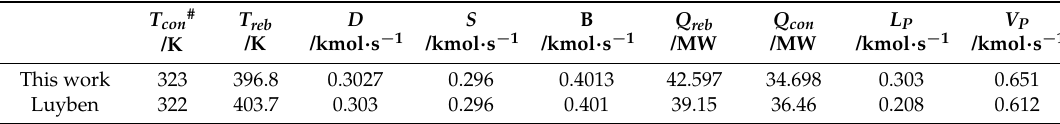
Table 1. Results comparison between this paper and Luyben